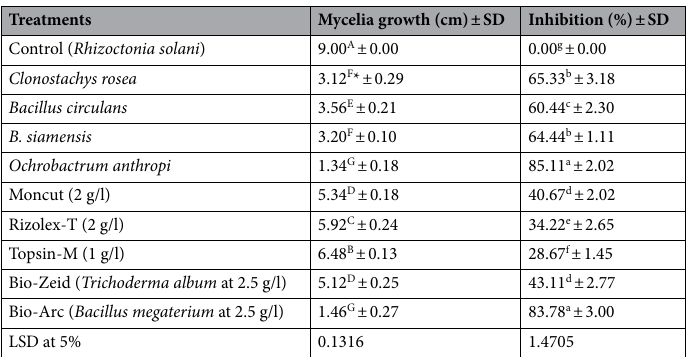
Table 7. The in vitro inhibition of the tested bioagents, and certain fungicides and biocides on mycelia growth (cm) of Rhizoctonia solani grown on PDA after six days at 26 °C. *Values are means of five replicate plates, values within the same column followed by different letter(s) are significantly different at 0.05 of probability.